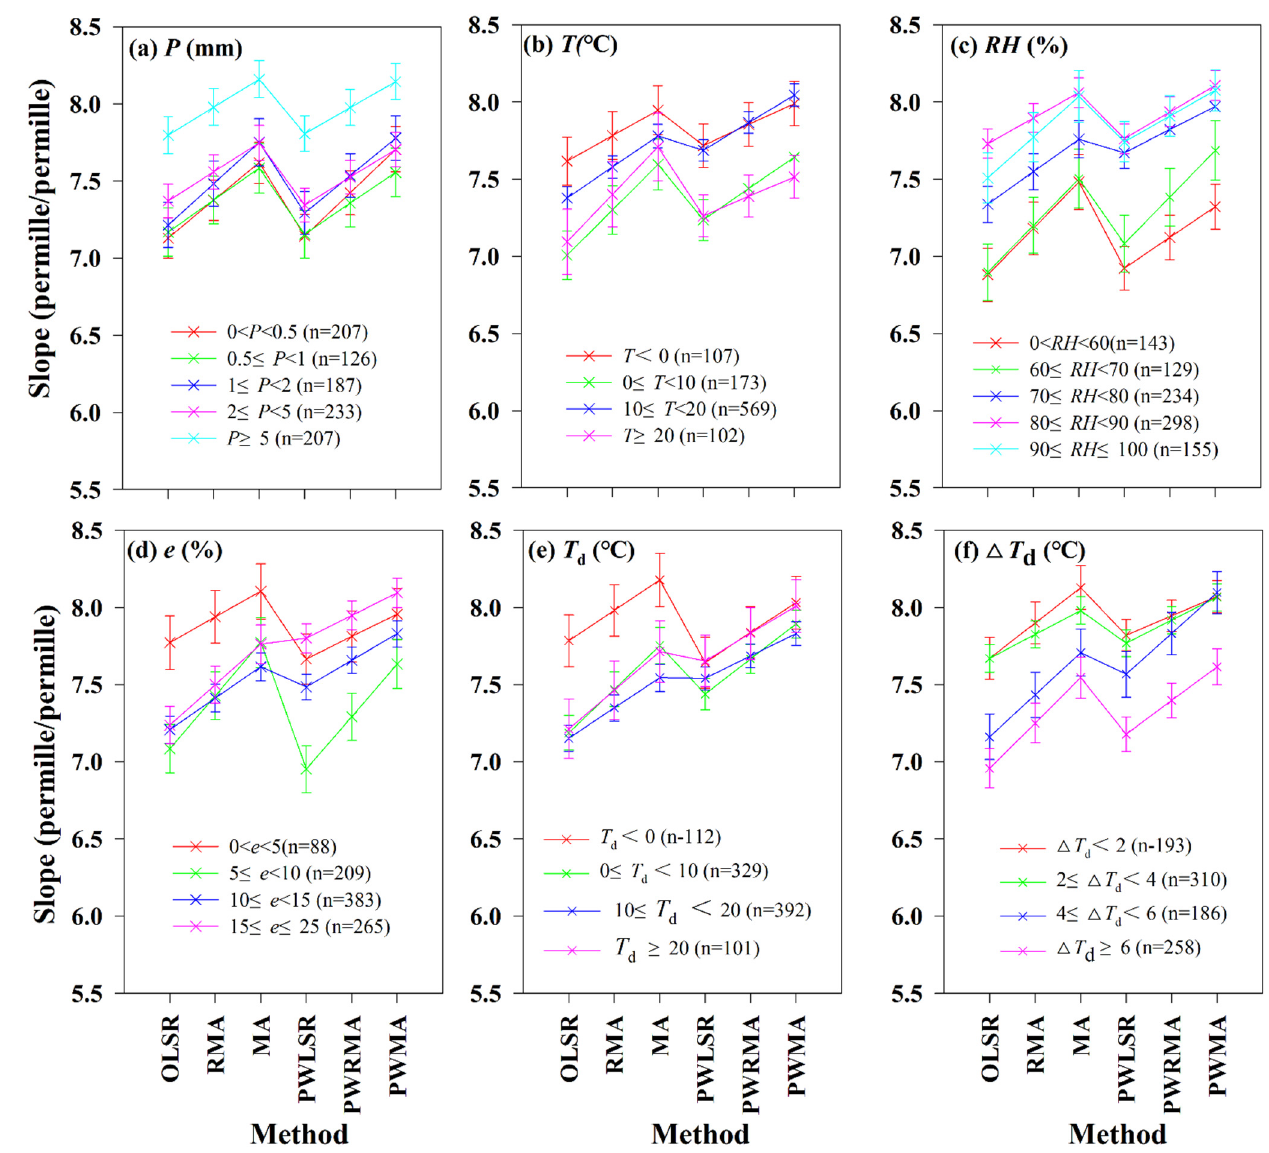
Figure 9. The slopes of LMWL under different meteorological conditions (( a ) P -precipitation amount, ( b ) T -air temperature, ( c ) RH -relative humidity, ( d ) e -water vapor pressure, ( e ) T d -dew point temperature, ( f ) Δ T d -depression of dew point) using six regression methods for all sampling stations in Lanzhou from 2011 to 2014.